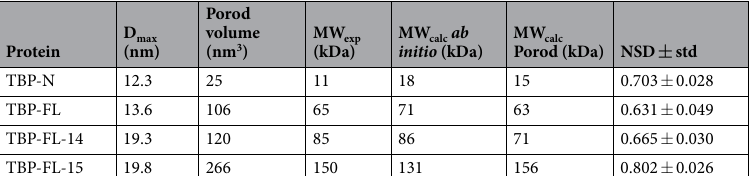
Table 1. Summary of SAXS analysis. MW exp = expected molecular weight, MW calc Porod = calculated molecular weight obtained by dividing the Porod volume by 1.7, MW calc ab initio = calculated molecular weight obtained from DAMAVER, NSD = normalized spatial discrepancy for ab initio